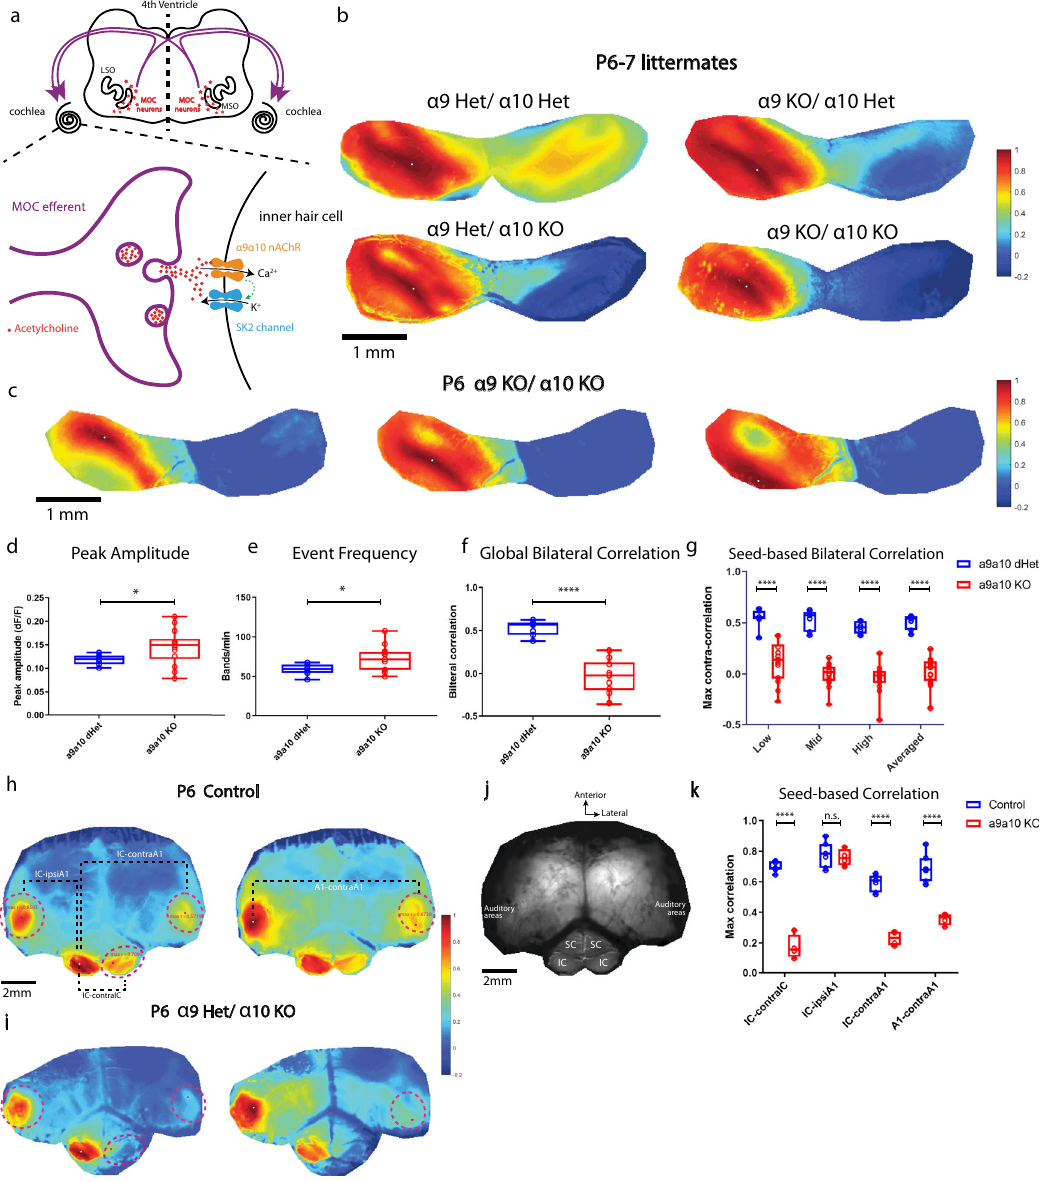
Fig. 2 α 9/ α 10 nAChR knockouts lack bilateral coupling of spontaneous activity in IC and A1. a Top panel: Schematics of the medial-olivocochlear (MOC) efferent circuits. LSO lateral superior olive, MSO medial superior olive. Purple curved arrows: cochleae receiving bilateral MOC feedback. Bottom panel: Simpli fi ed schematics of a transient synapse between a MOC efferent axon and an inner hair cell. α 9/ α 10 nAChR: alpha9/alpha10 nicotinic acetylcholine receptor. SK2 channel: KCNN2 potassium channel coupled with the α 9/ α 10 nAChR. b Example correlation maps showing correlation patterns in the IC among littermates of different genotypes at P6 – P7. Het heterozygous, KO knockout. Seeds (white dots) are all located in similar regions of the left IC. c Example IC correlation maps from a P6 α 9/ α 10 double knockout animal. Three typical representative seeds (white dots) located in the future low-, mid-, and high-frequency regions. d Average peak amplitude. Similar to Fig. 1d. d – g a9a10 dHet: α 9/ α 10 double heterozygous ( N = 7); a9a10 KO: include single/double knockout of either or both α 9/ α 10 subunits ( N = 14). e Event frequency. Similar to Fig. 1e. f Global bilateral correlation. Similar to Fig. 1j. g Seed-based bilateral correlation. Similar to Fig. 1k. h Example correlation maps with a large fi eld of view including both midbrain and cortex from a P6 SNAP25-G6s animal. Dashed magenta lines: ROIs de fi ned to quantify maximum regional correlations. Left panel: Reference seed is in the left IC (white dot). IC-ipsiA1: Correlation between the ipsilateral IC (w.r.t the seed) and the ipsilateral A1. IC-contraA1: Correlation between ipsilateral IC and contralateral A1. IC-contralIC: Correlation between ipsilateral IC and contralateral IC hemispheres. Right panel: Reference seed is in the left A1 (white dot). A1-contraA1: Correlation between the ipsilateral A1 where the seed locates and the contralateral A1. A number of control animals (SNAP25-G6s) = 7. i Example correlation maps with a large fi eld of view including both midbrain and cortex from a P6 α 9 Het α 10 KO animal. A number of α 9/ α 10 KO animals = 4. j Field of view (grayscale mean fl uorescent image) over the cortex and the midbrain. SC superior colliculi, IC inferior colliculi. Scale bar indicates 2mm. k Seed-based correlation. IC-contralIC: Correlation between ipsilateral and contralateral IC. IC-ipsiA1: Correlation between ipsilateral IC and ipsilateral A1. IC-contraA1: Correlation between ipsilateral IC and contralateral A1. A1-contraA1: Correlation between ipsilateral A1 and contralateral A1. Box plot symbols similar to ( g ). n.s. p >0.05, ∗ p <0.05, ∗∗ p <0.01, ∗∗∗ p <0.001, **** p <0.0001, two- tailed unpaired t test with Welch ’ s correction. d p = 0.0228, e p = 0.0133, f **** p <0.0001, g **** p <0.0001, k n.s. p = 0.69495, **** p <0.0001. Source data and exact p values are provided as a Source Data fi